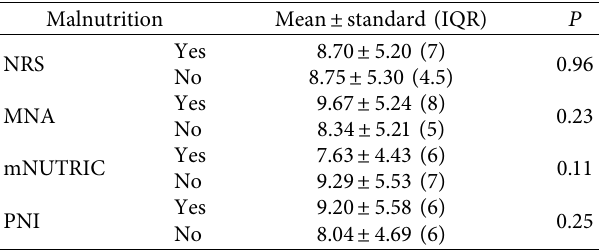
Table 5: Length of ICU stay in normal and malnourished patients. Malnutrition